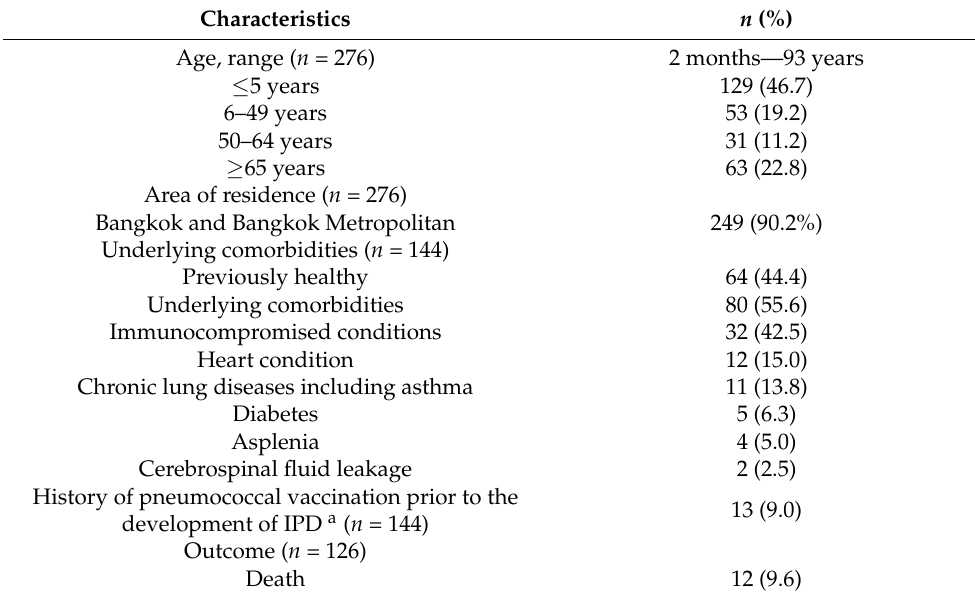
Table 1. Characteristics of patients with invasive pneumococcal diseases with available clinical data in Central Thailand,